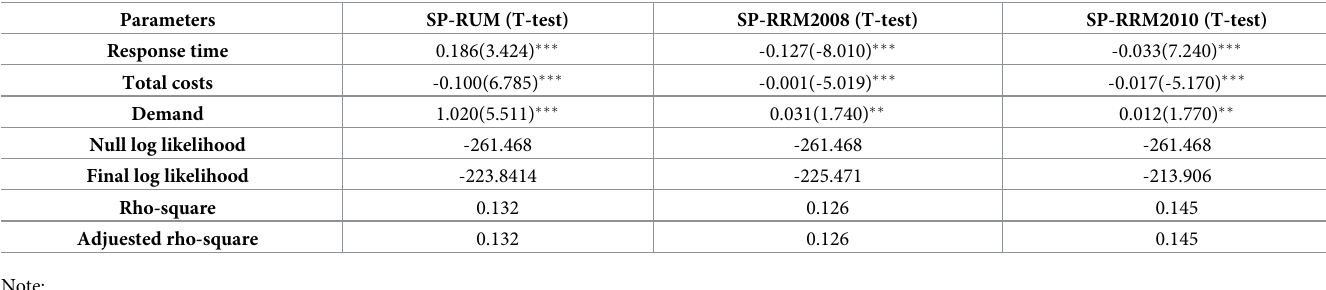
Table 8. Estimation results for different models with the